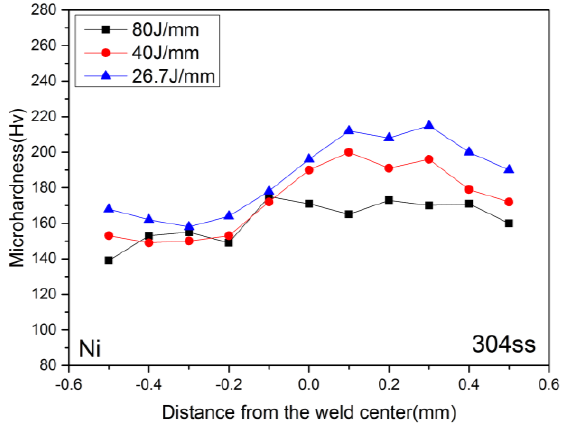
Figure 14. Spatial distribution of Vickers hardness along the transverse section of the fusion zone.